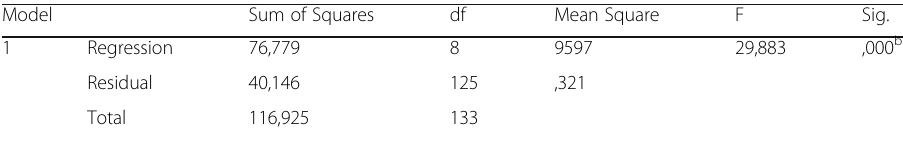
Table 22 ANOVA (R4) a